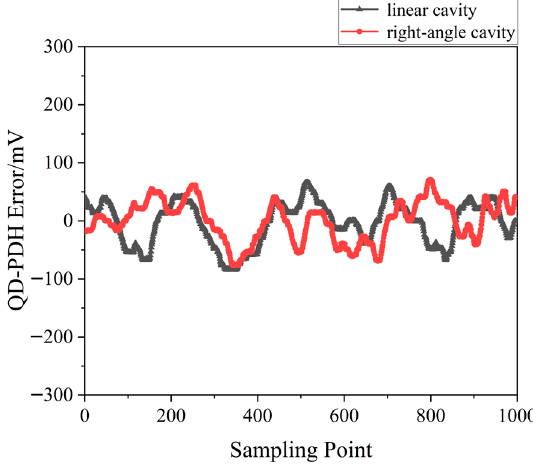
Figure 43. Error signals of the frequency-locked QD-PDH subsystems [44].